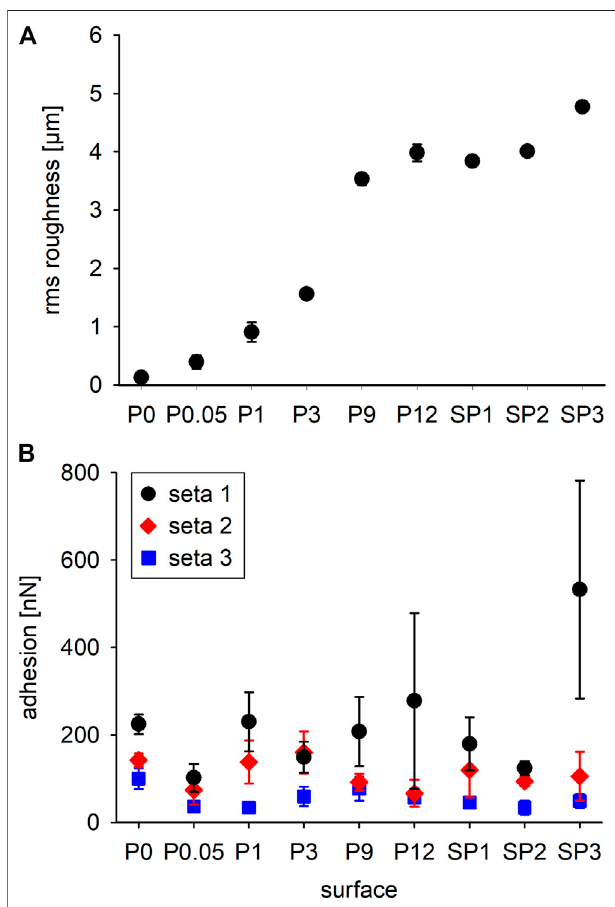
FIGURE 7 | (A) Mean root mean square roughness ( ± standard deviations; n (cid:2) 5 measurements on different spots of each sample) of the different tested epoxy resin surfaces shown in Figure 6 . P0 is the mold of a glass surface, P0.05 – P12 are the molds of polishing papers, and SP1 – SP3 are the molds of different sand papers. (B) Adhesion forces of individual setae (mean values ± standard deviations; 36 measurements each) on different rough surfaces after 500 nN perpendicular